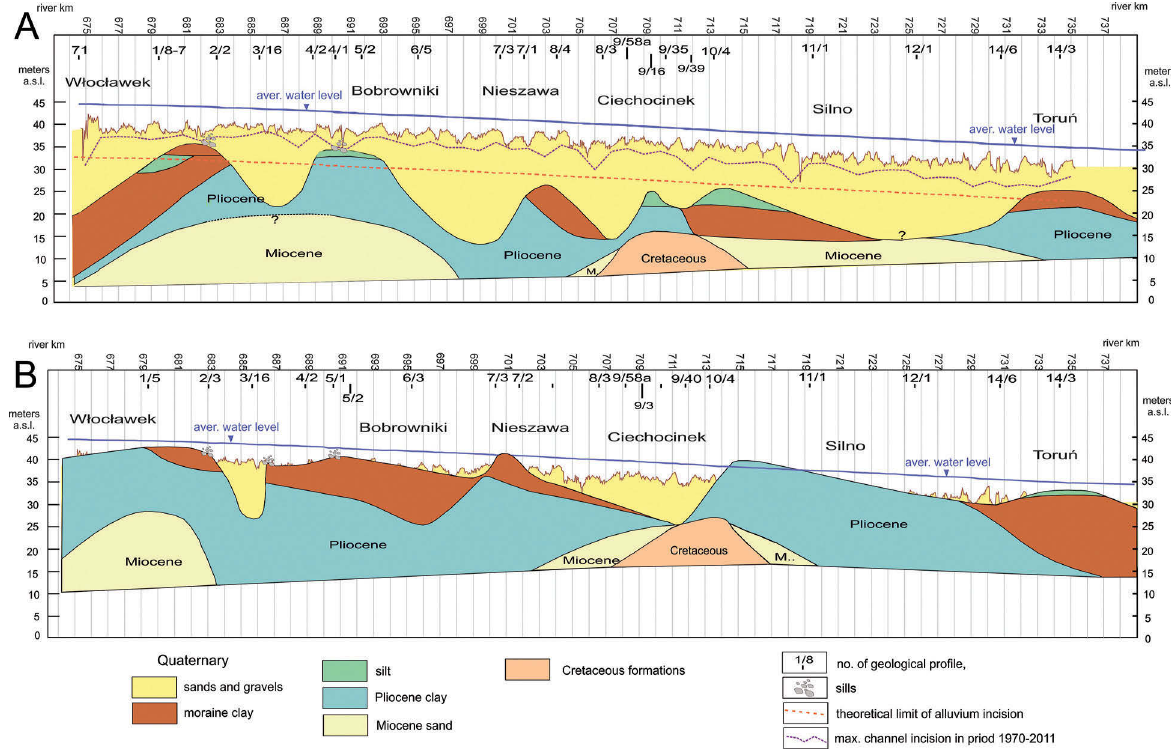
Fig. 3. Geological longitudinal profiles of the Vistula bed; the course of the maximum (A) and minimum (B) incision of the river channel during the Holocene